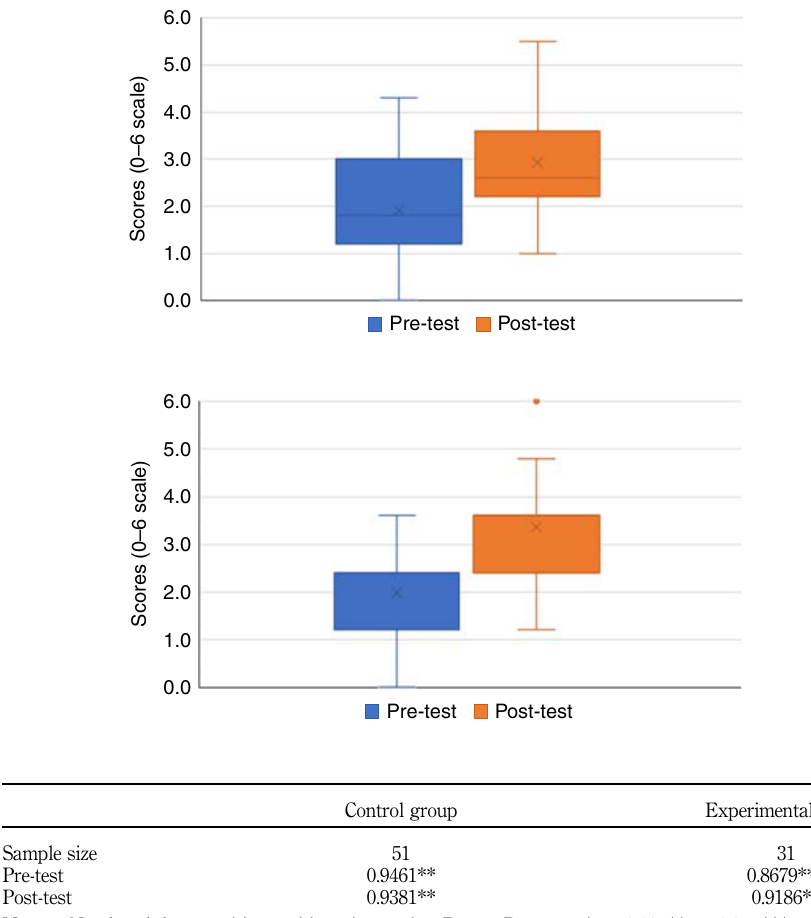
Table I. Test for normality – Shapiro- Wilk normality test ( W )